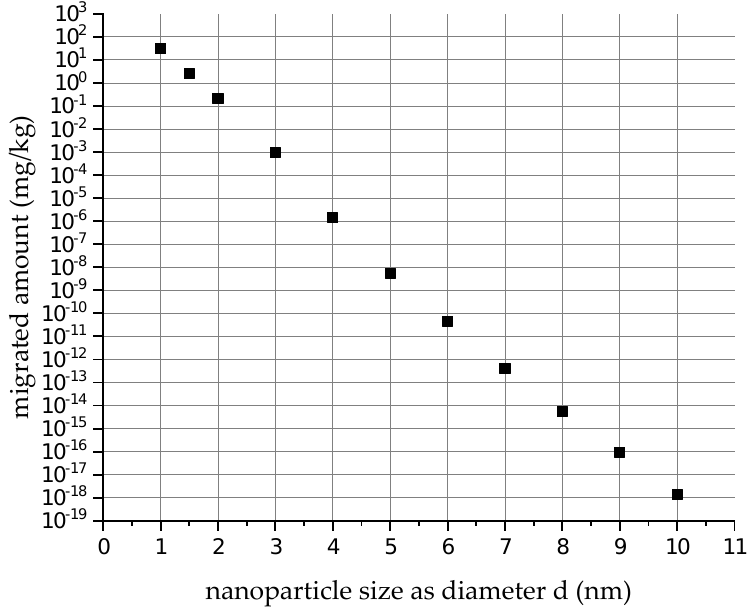
Figure 2. Calculated migration into food (1 kg) after contact (10 day at 40 ◦ C) with 6 dm 2 LDPE of 3 mm thickness as a host polymer for nanoparticles with distinct sizes from 1 to 10 nm in diameter if monomodally present each at 1000 ppm in polymer.